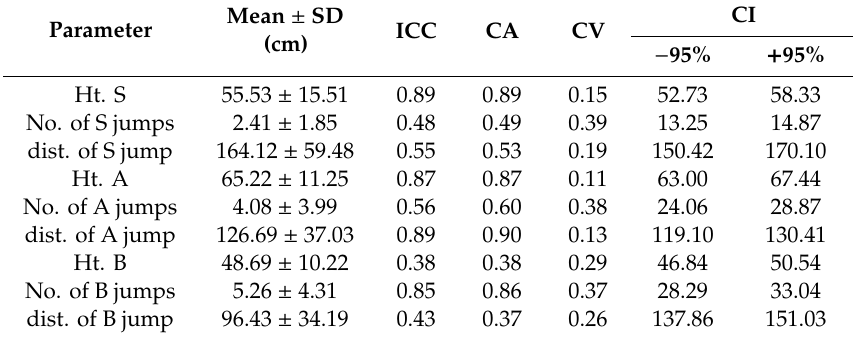
Table 1. Descriptive statistics and reliability coe ffi cients for the tests used in this study.